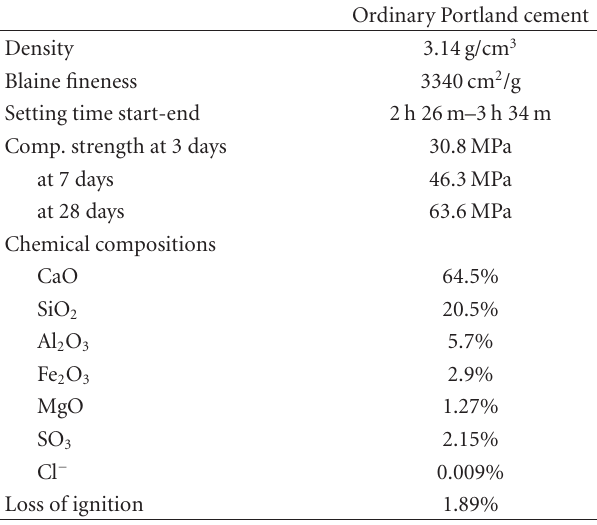
Table 1: Physical and chemical compositions of cement.